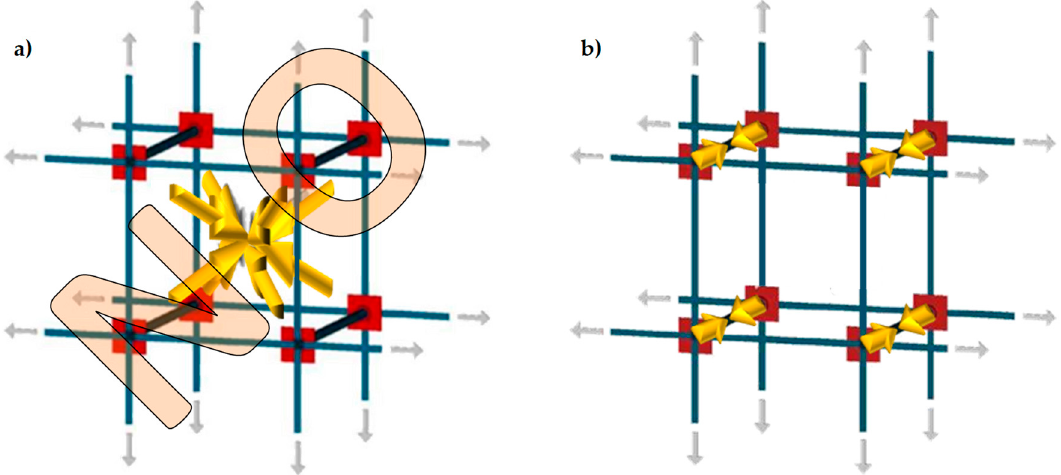
Figure 6. Schemes of stress transfer from the CAM system to the masonry wall: ( a ) assumption of hydrostatic state of stress and ( b ) actual scheme of stress transfer.